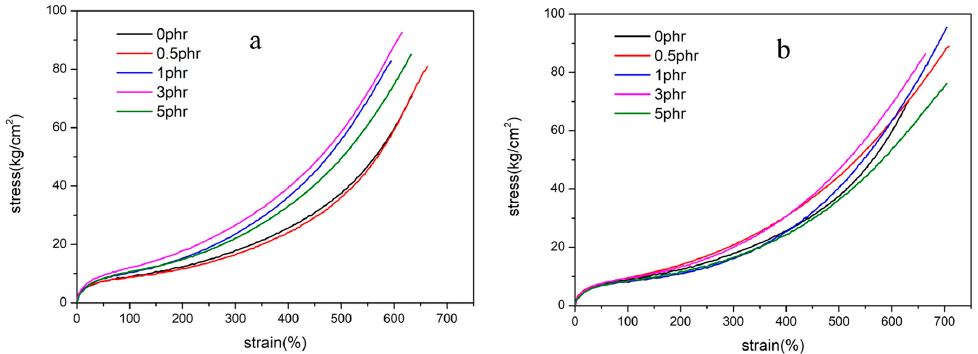
Figure 9. Stress-strain curves: ( a ) MoS 2 -ethanethiol-butyl and ( b ) MoS 2 -nonanethiol-butyl rubber.